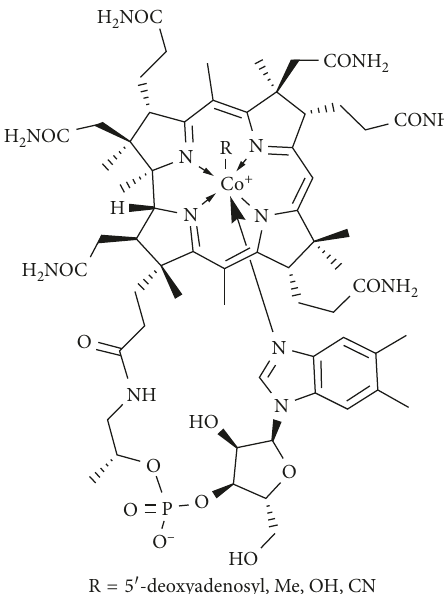
Figure 1: Vitamin B 12 chemical